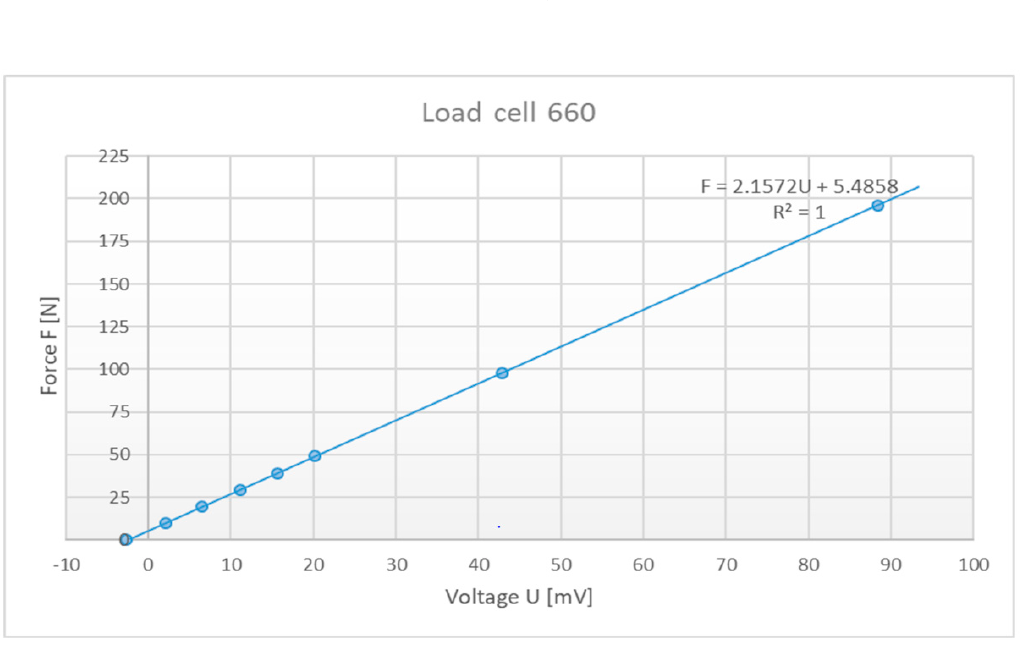
Figure 16. Voltage—force ratio graph for load cell 1 (660).